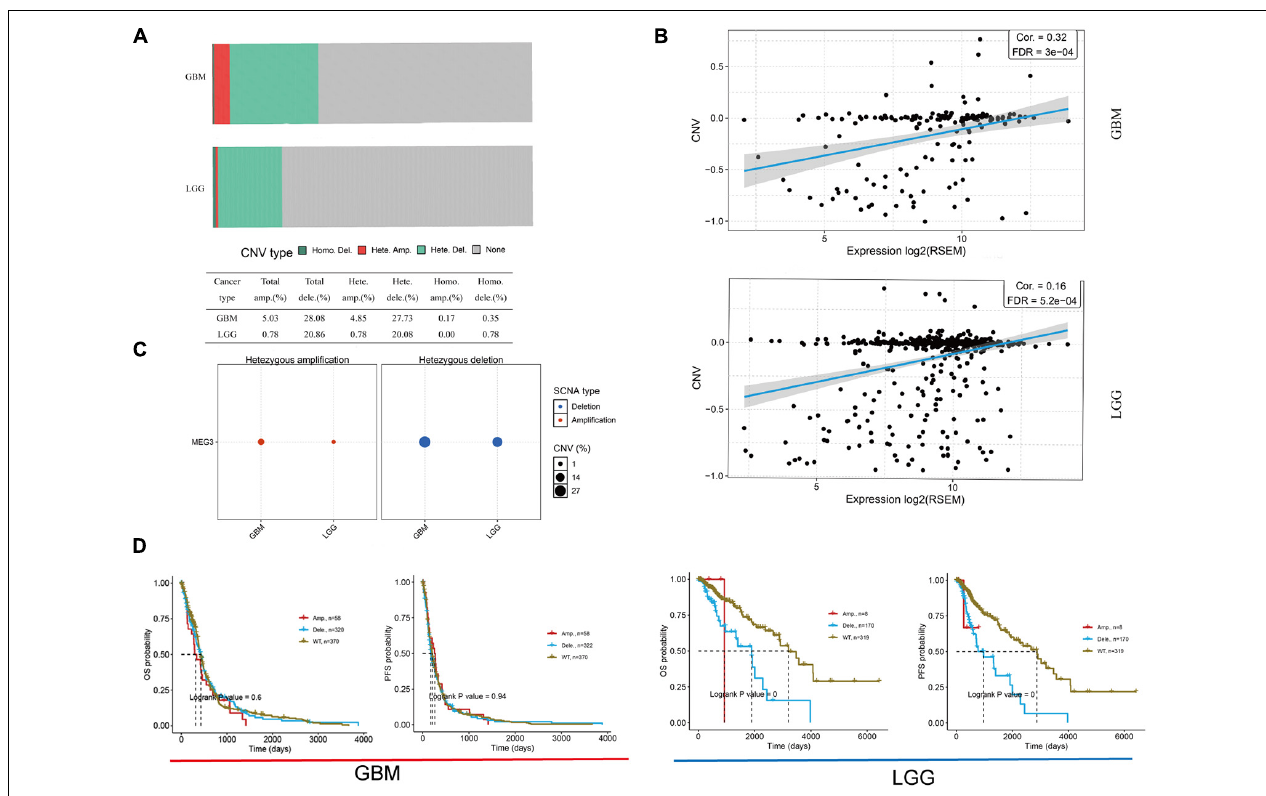
FIGURE 2 | Copy number variation (CNV) of MEG3 expression in both GBM and LGG by using GSCALite database. (A) CNV distribution of MEG3 in GBM and LGG tumor samples. (B) Spearman correlation between MEG3 CNV and mRNA expression in GBM and LGG. (C) Heterozygous CNV in each cancer. (D) OS and PFS of MEG3 CNV in GBM and